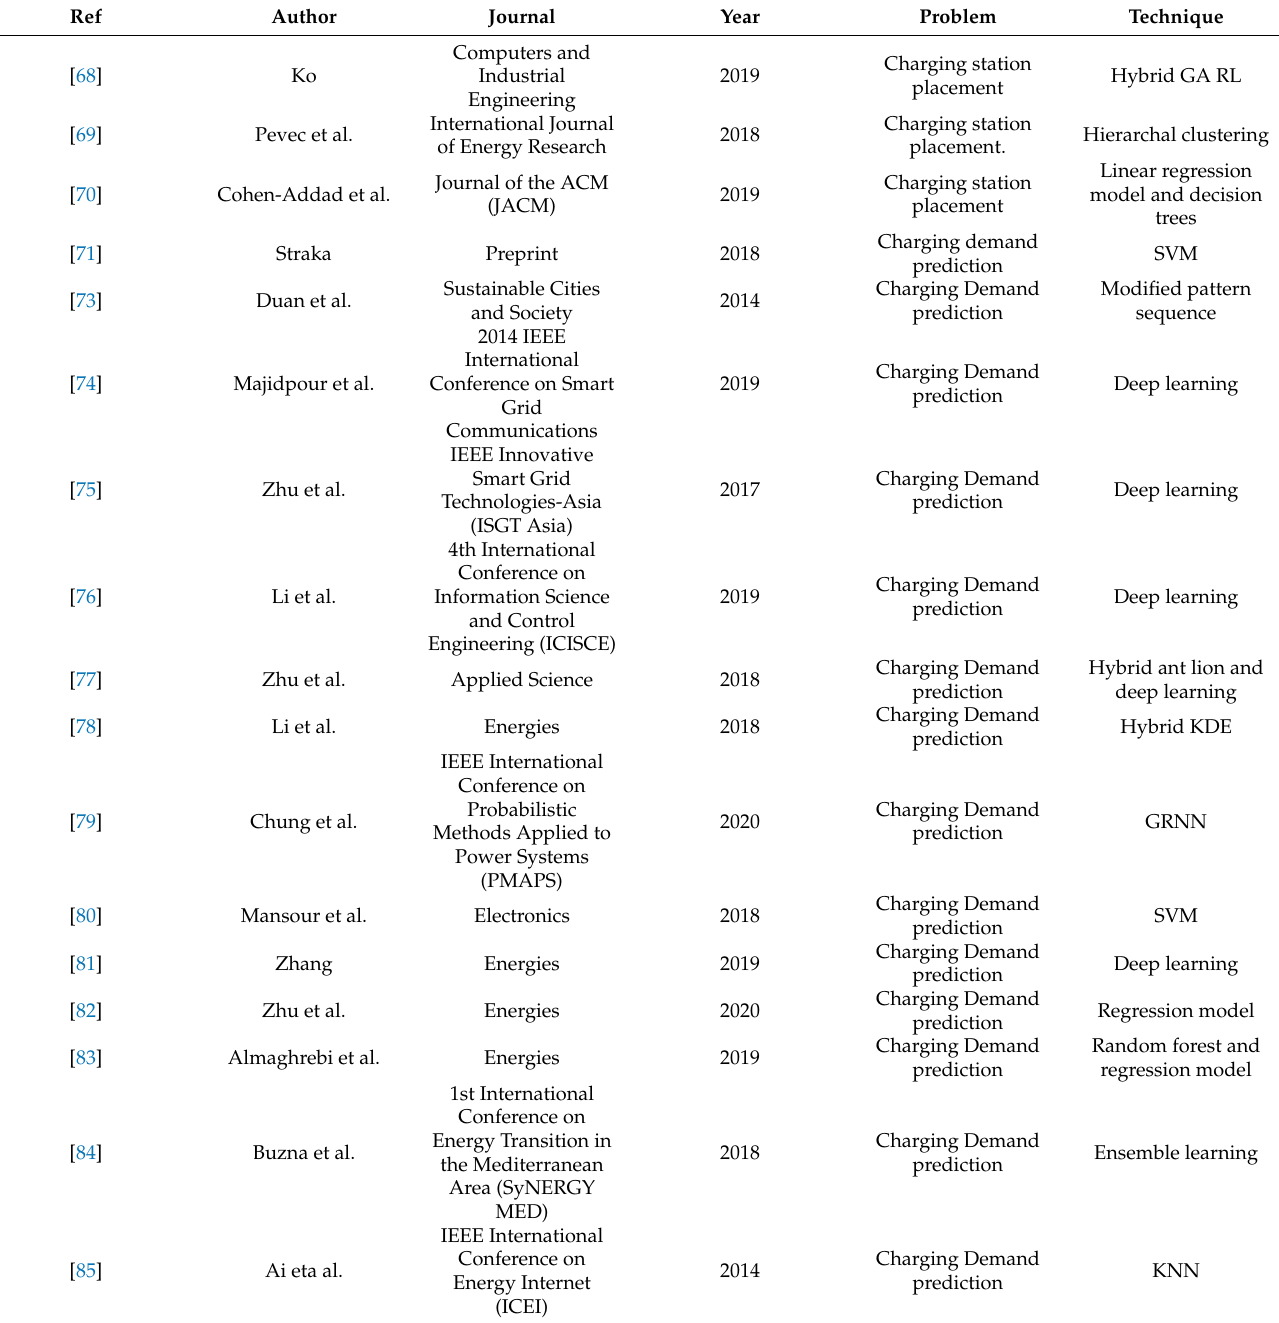
Table 3. Summary of the research concerning the use of machine learning for charging infrastructure